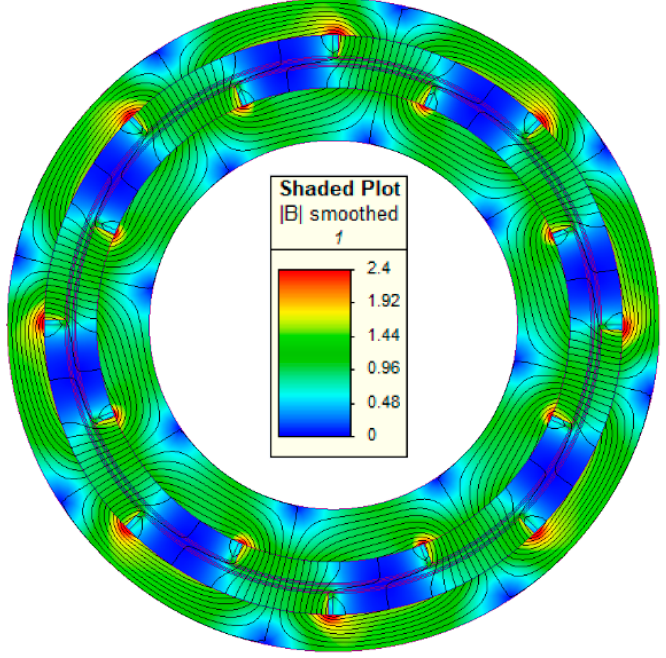
Figure 5. Flux density distribution and flux lines at the maximum torque point.